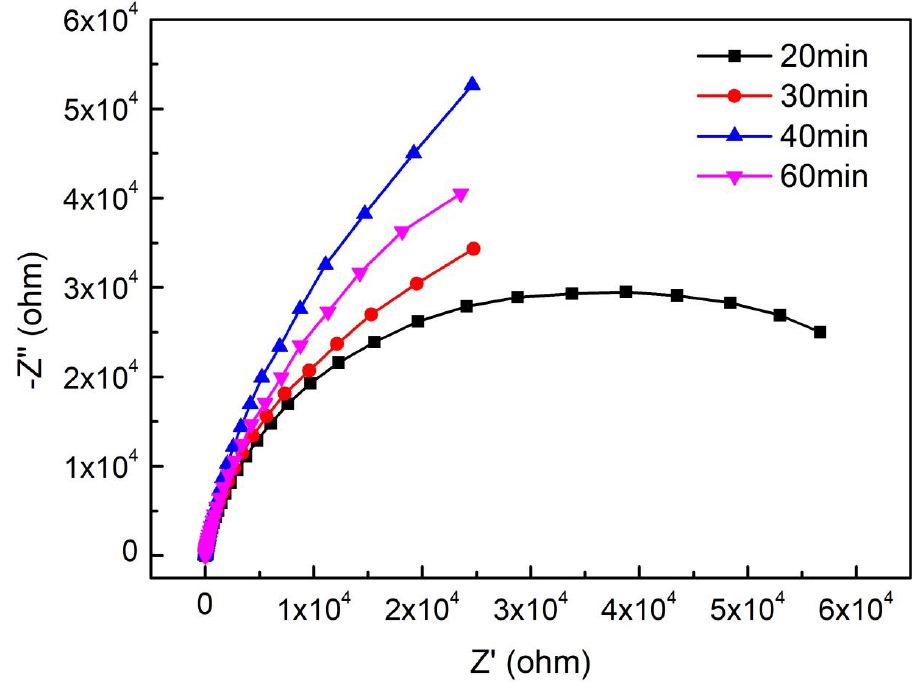
Figure 12. Nyquist curves of S32750 stainless steel at di ff erent annealing